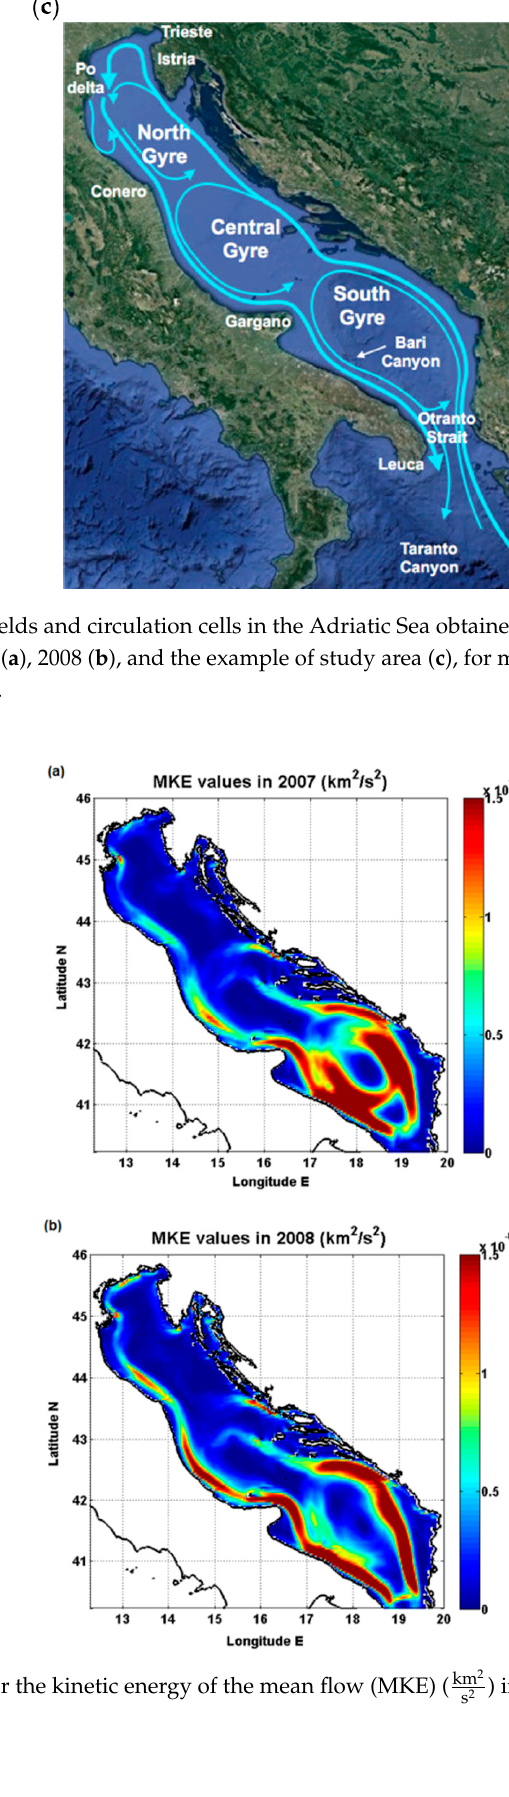
Figure 2. Values for the kinetic energy of the mean flow (MKE) ( km 2